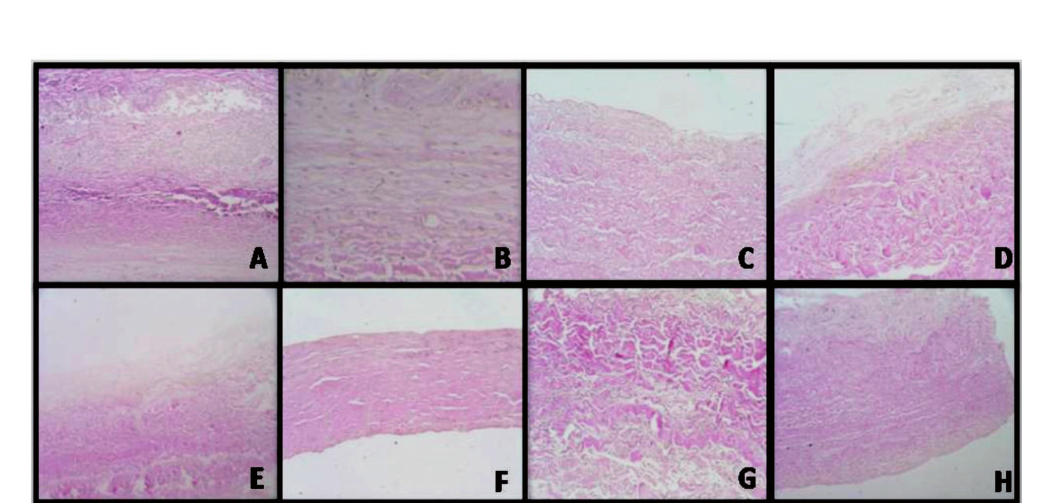
Fig. 2 - Amostras de pericárdio bovino após explante e coradas com HE. A- GDA 45 dias; B – GDA-GL 45 dias; C- D-GDA 45 dias; D –GDA-GL 45 dias; E - GDA 90 dias; F– GDA-GL 90 dias; G – D-GDA 90 dias; H –D- GDA-GL 90 dias. Podemos observar o infiltrado inflamatório e a arquitetura da matriz. A menor intensidade